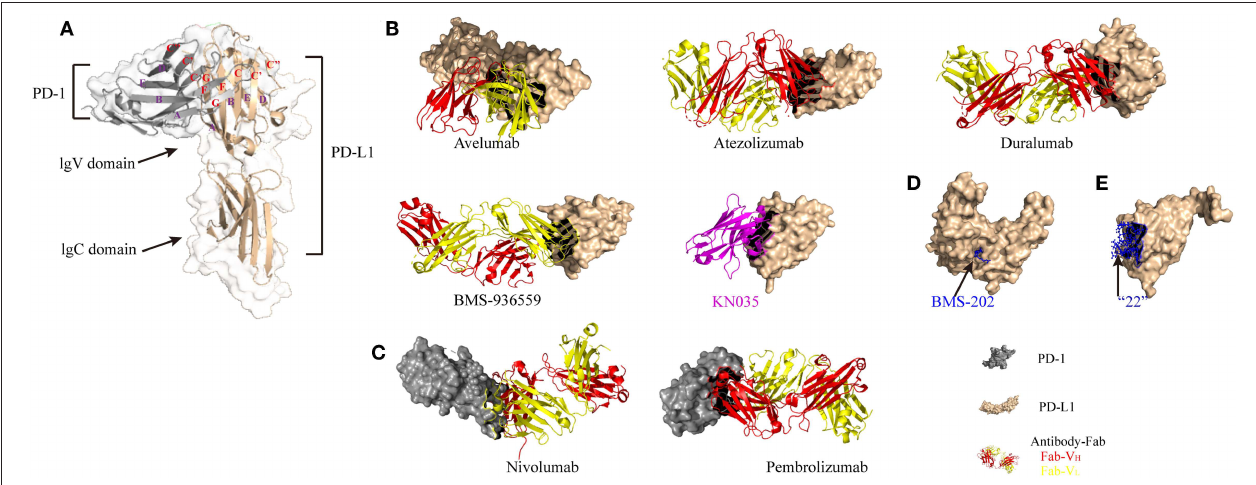
FIGURE 1 | Structural basis of PD-1/PD-L1 checkpoint blockade by antibodies and small molecules. (A) Structure of the PD-1 and PD-L1 complex (modified from PDB ID 3BIK). (B) Overall structure of the hPD-L1 and avelumab-Fab complex, the hPD-L1 and atezolizumab-Fab complex, the hPD-L1 and durvalumab-Fab complex, the hPD-L1 and BMS-936559-Fab complex, and the hPD-L1 and KN035 nanobody complex (magenta ribbon model) (modified from PDB IDs 5GRJ, 5X8L, 5X8M, 5GG7, and 5JDS, respectively). The heavy chain (V H ) and the light chain (V L ) of the antibody-Fab fragments are represented by red and yellow ribbon models, respectively. (C) Overall structure of the hPD-1 and nivolumab-Fab complex and the hPD-1 and pembrolizumab-Fab complex (modified from PDB IDs 5GGR and 5GGS, respectively). (D) Crystal structure of BMS-202 (non-peptide small molecule inhibitor, blue stick model) on the surface of hPD-L1 (light yellow ribbon structure) (modified from PDB ID 5J89). (E) Structure of macrocyclic peptide inhibitor “22” in complex with hPD-L1 (light yellow ribbon model = hPD-L1; blue ball and stick model = peptide) (modified from PDB ID